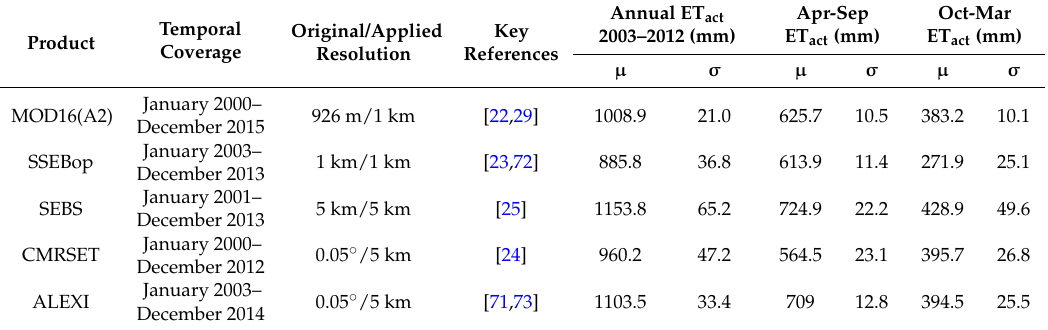
Table 3. Properties of evaluated ET act products for the Red River Basin. The basin-wide mean ET act ( µ ) and year-to-year standard deviation ( σ ) are reported for the overlapping period (January 2003–December 2012). Temporal coverages indicate the time series of each product that were (made) available for this